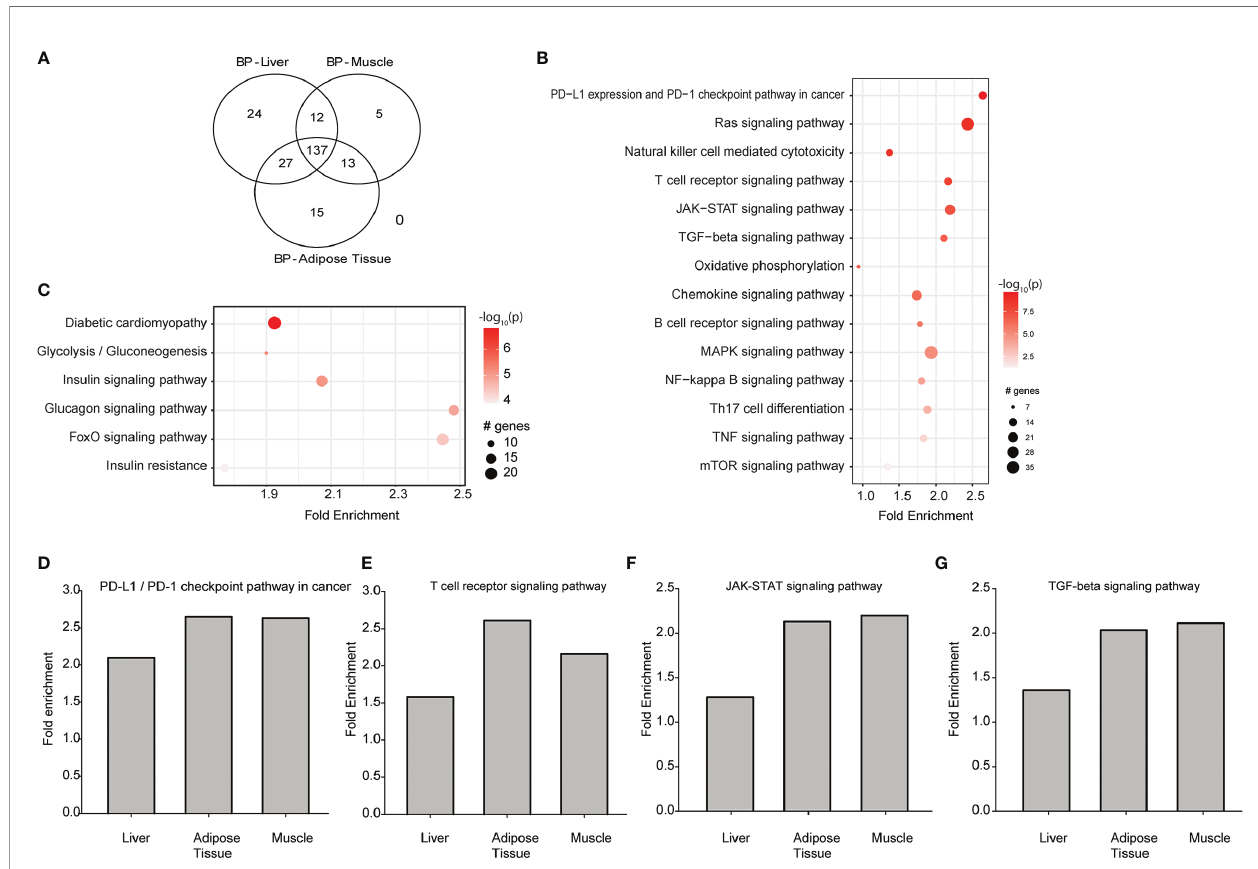
FIGURE 4 | Transcriptomic re-analysis of 3 principal diabetic tissues (liver, muscle and adipose tissue) in Wistar rats compared to GK rats. (A) Venn diagram showing the number of common biological pathways. (B) Biological pathways that are regulated by downstream signalling from circulating cytokines analysed in the muscle. (C) Biological pathways associated with diabetes and its complications analysed in the muscle. For (B, C) , the intensity of the colour is proportional to the -log 10 of P-value, sizes of the circles represent the number of genes involved, while placement of the circles on the x axis indicates the fold enrichment. (D – G) Are T-cell receptor signalling, Jak-STAT signalling, TGF- b signalling and PDL1 signalling respectively in liver, muscle and adipose tissue. Data from GSE13271